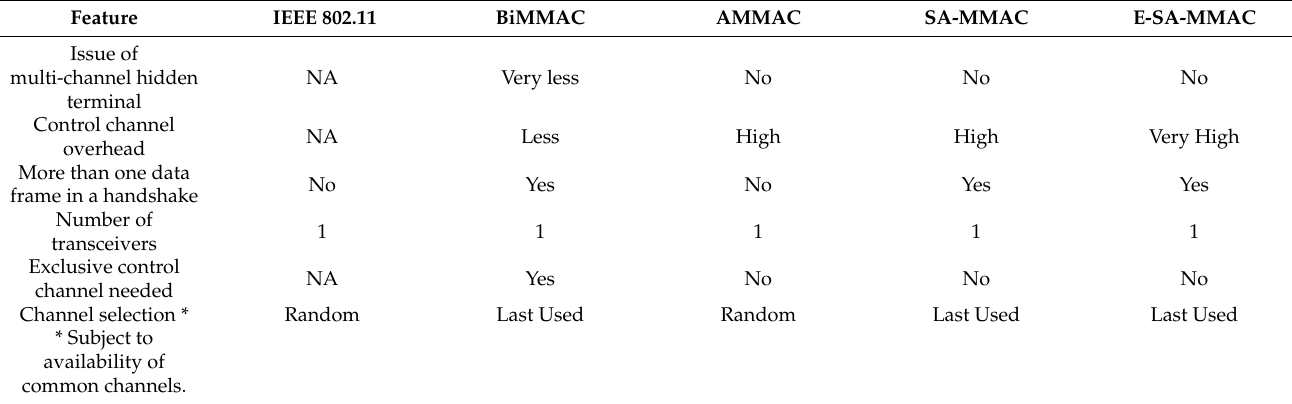
Table 1. Comparison of features.